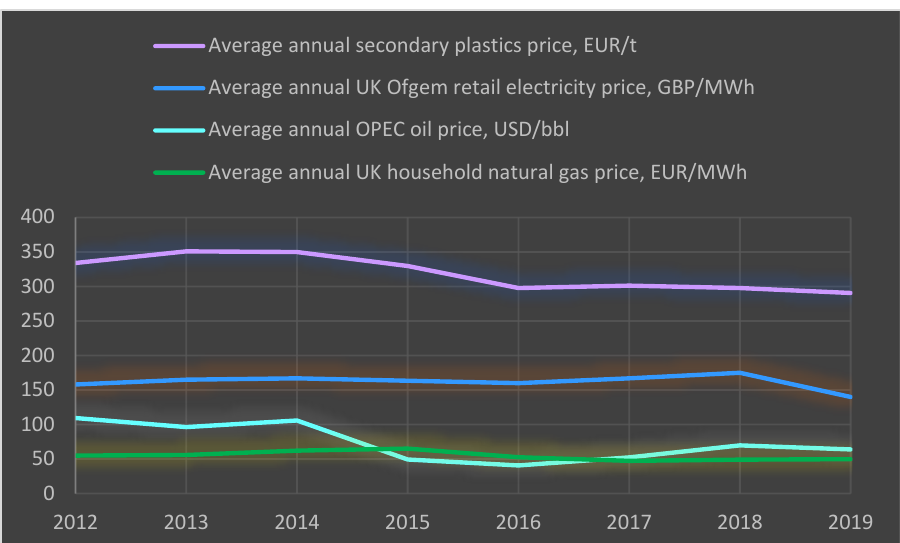
Figure 2. Average annual secondary plastics, UK retail electricity, OPEC oil, and UK household natural gas prices from 2012 to 2019.